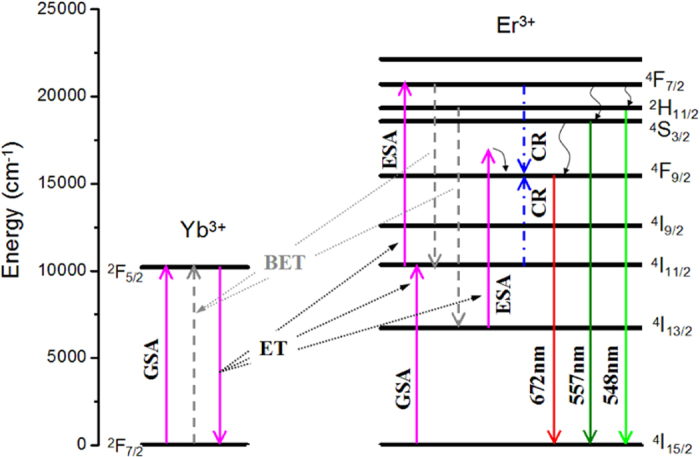
The energy level diagram.Energy level diagram of Yb3+ and Er3+ and the proposed UC mechanism in Ba5Gd8Zn4O21:Yb3+, Er3+.